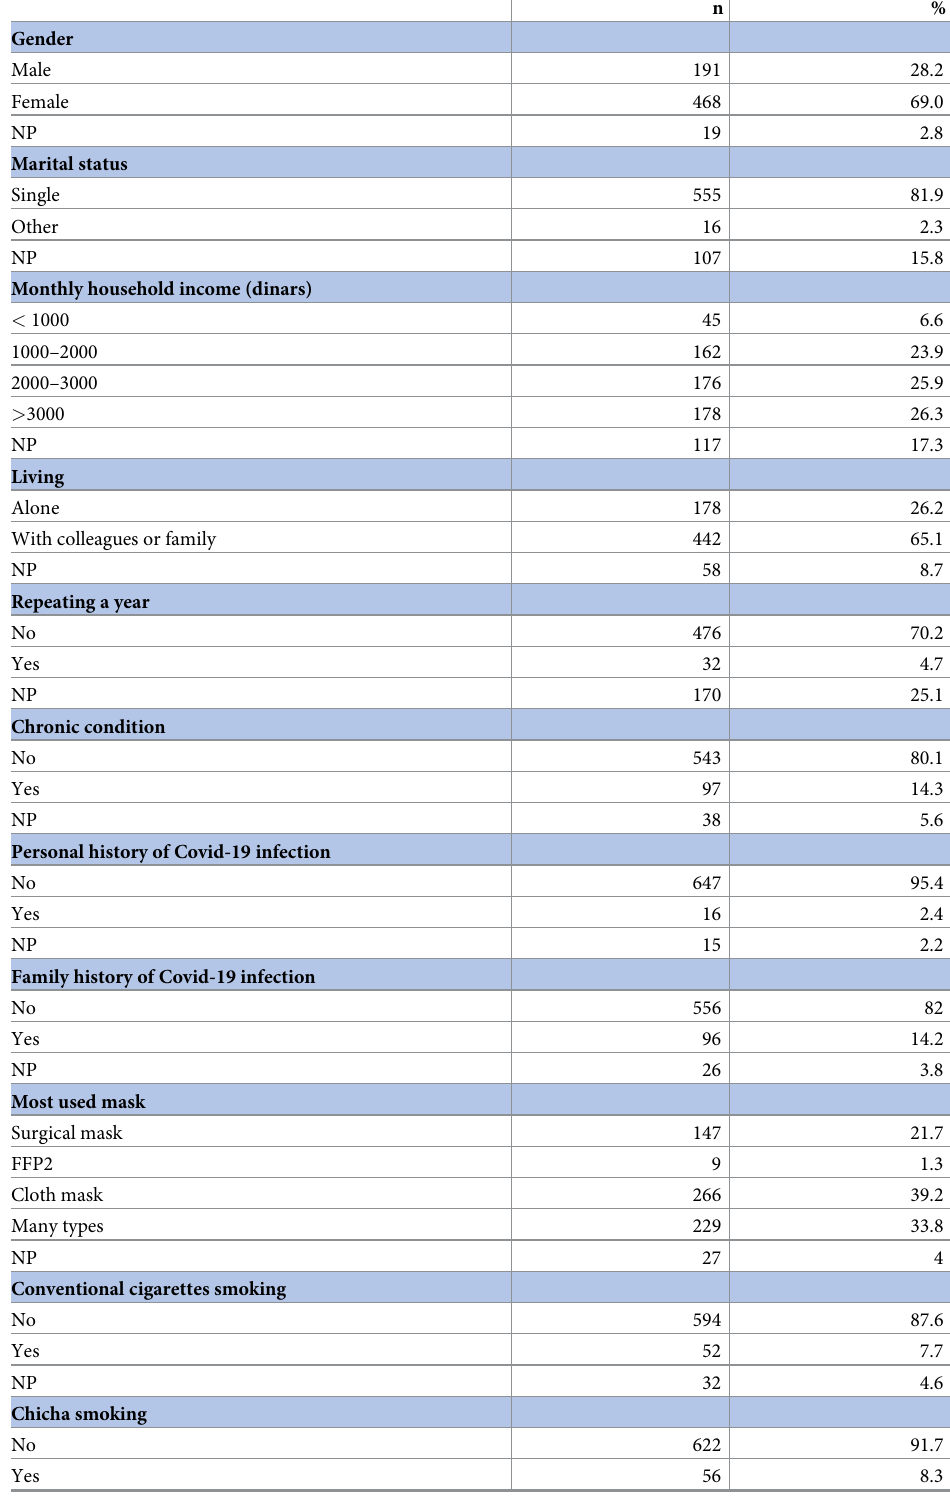
Table 1. General characteristics of the study